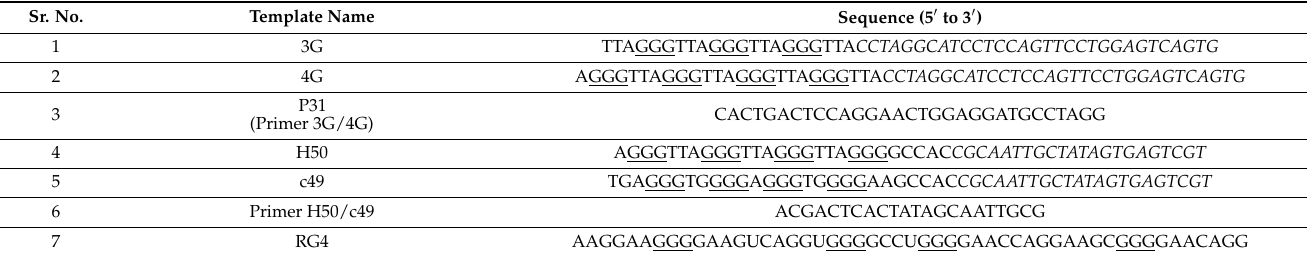
Figure 1. Structure of dimeric carbocyanine dye B6,5.